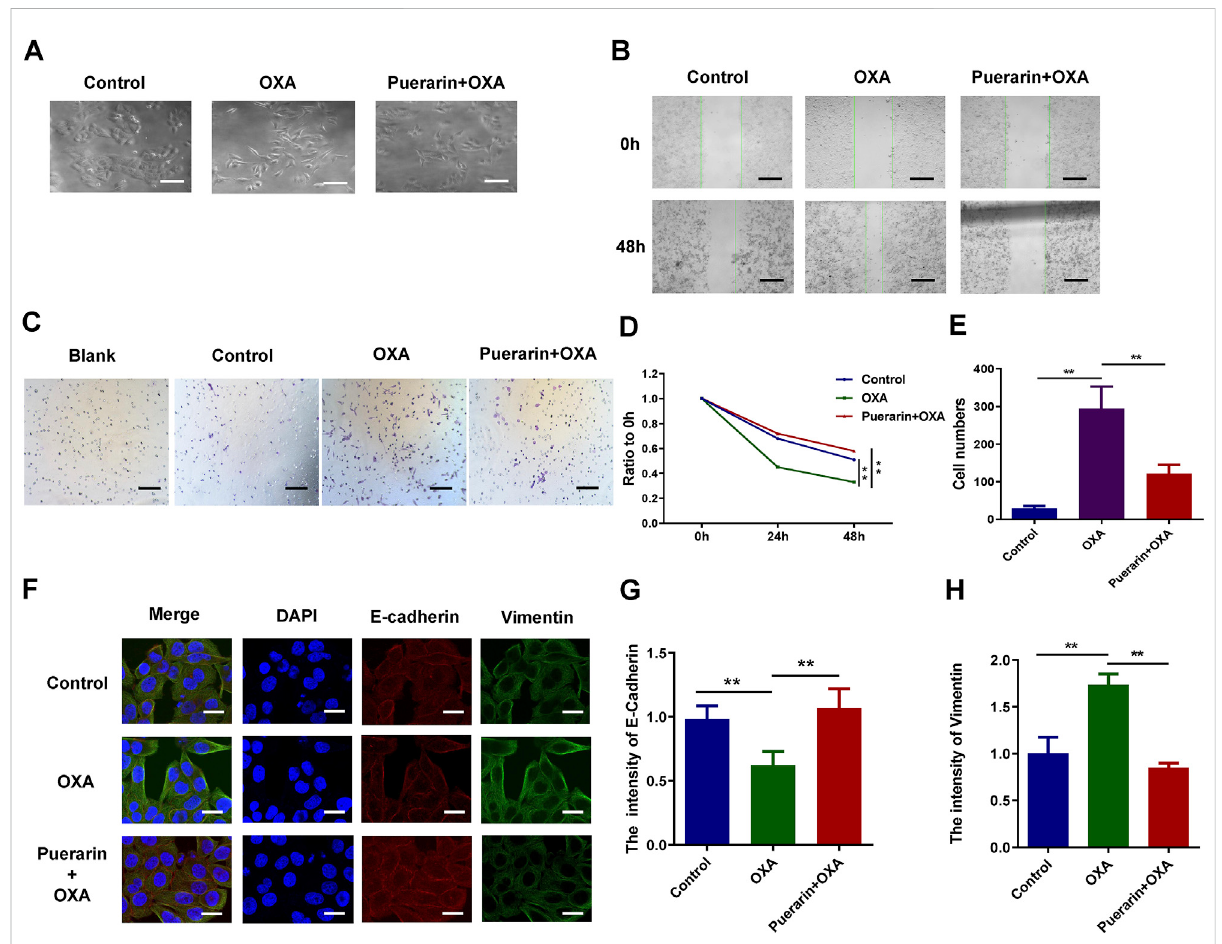
Puerarin inhibited migration and invasion and reversed EMT. (A) Morphological changes of the cancer cells in different treatment groups observed by a microscope (B,D) The results of wound-healing assay. (C,E) The results of transwell assay (F – H) The results of immuno fl uorescence (* p < 0.05, ** p <